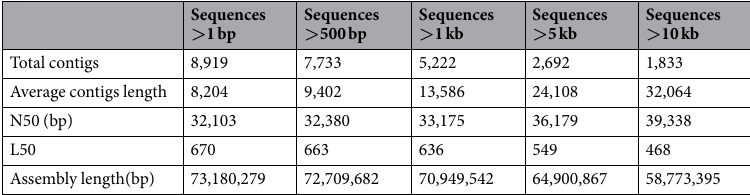
Table 1. Results obtained after CAP3 assembly.